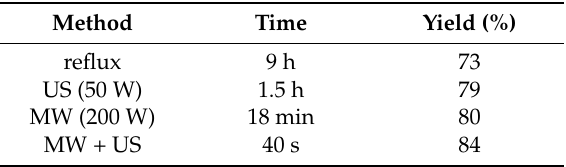
Table 5. Hydrazinolysis of methyl